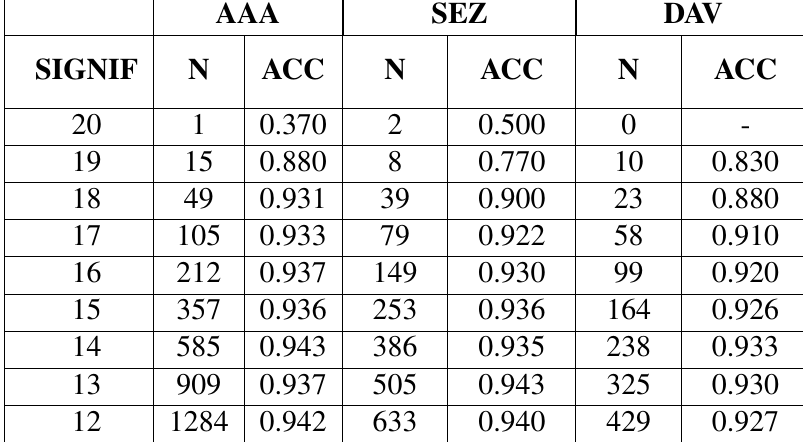
Table 4: Classification results with t-test-based subset selection, with subsets of features that are significant in a given number of t-tests, from 20 down to